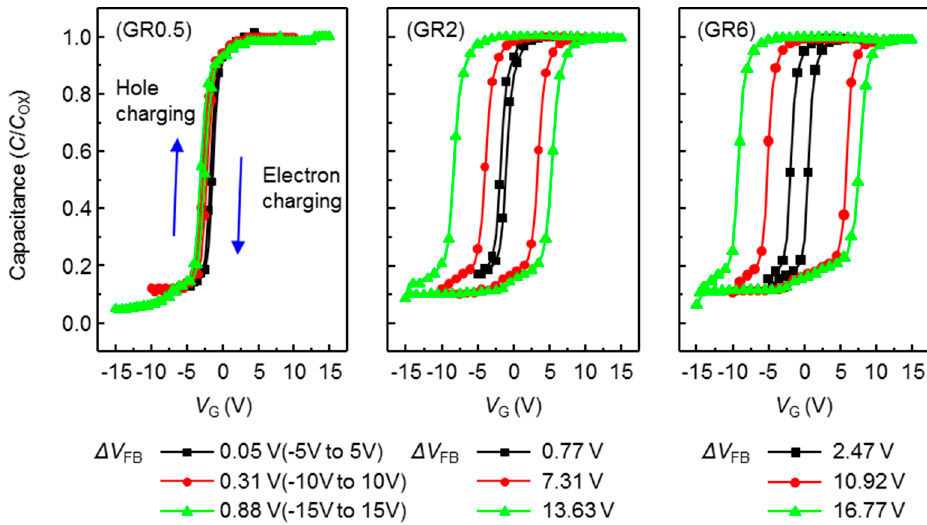
Figure 3. The capacitance-voltage characteristics curves of the Metal/SiO 2 /SiO X /SiO X N Y /Silicon capacitor with different SiH 4 :N 2 O gas ratio for Si-rich SiOx charge trapping layer; the flat band voltage shift ( Δ V FB ) (sweep voltage range) are 0.05 V ( − 5–5 V), 0.31 V ( − 10–10 V), and 0.88 V ( − 15–15 V) for black, red, and green lines, respectively.